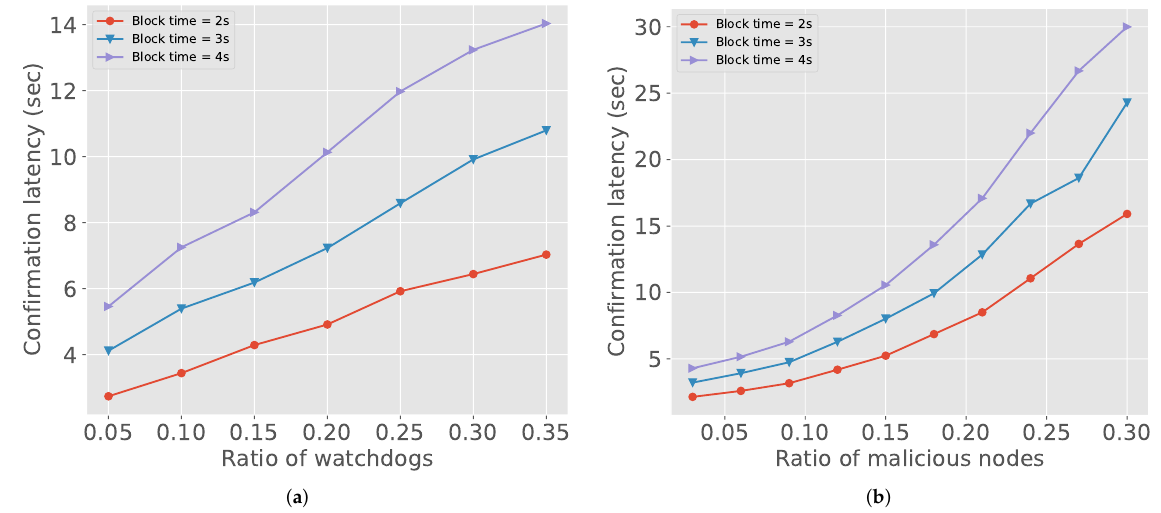
Figure 4. Confirmation latency: ( a ) number of watchdogs vs. confirmation latency; and ( b ) number of malicious nodes vs. confirmation